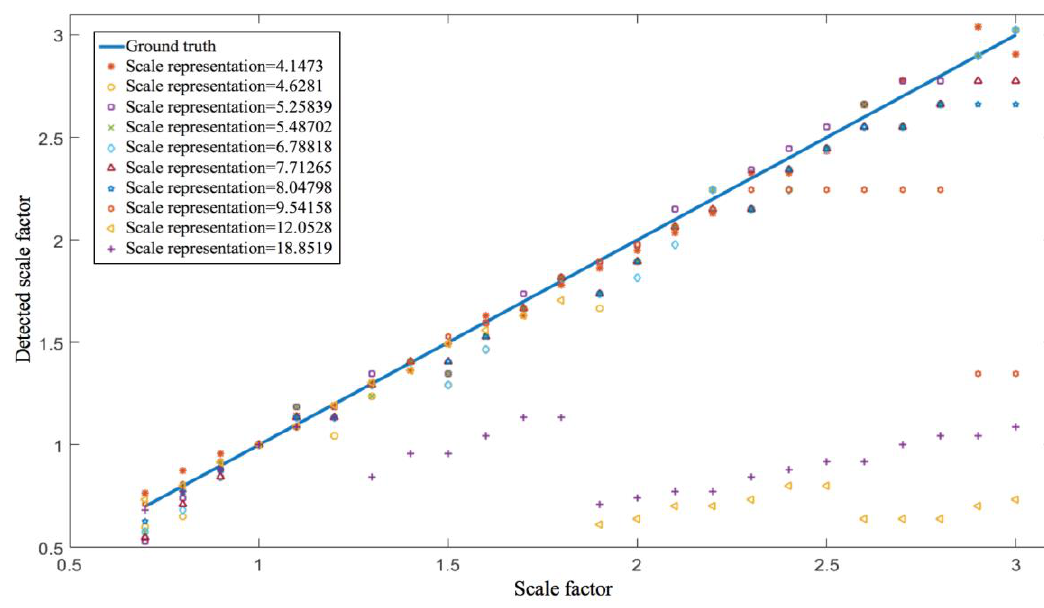
Figure 9. Scale factor calculation verification.